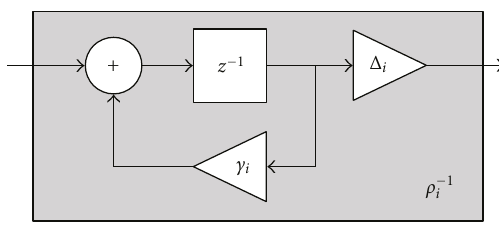
Figure 3: Realization of operator ρ − 1 i .